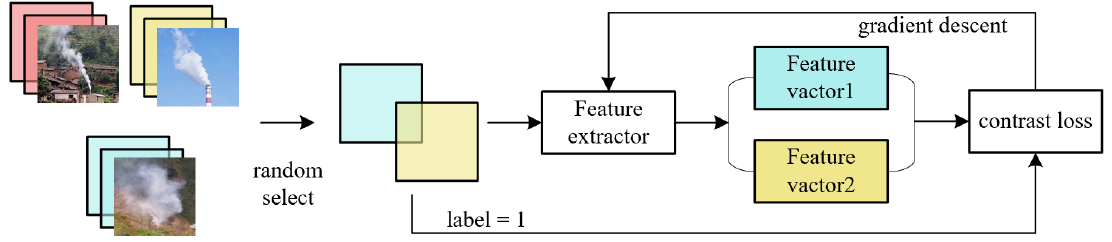
Figure 6. Network training process.